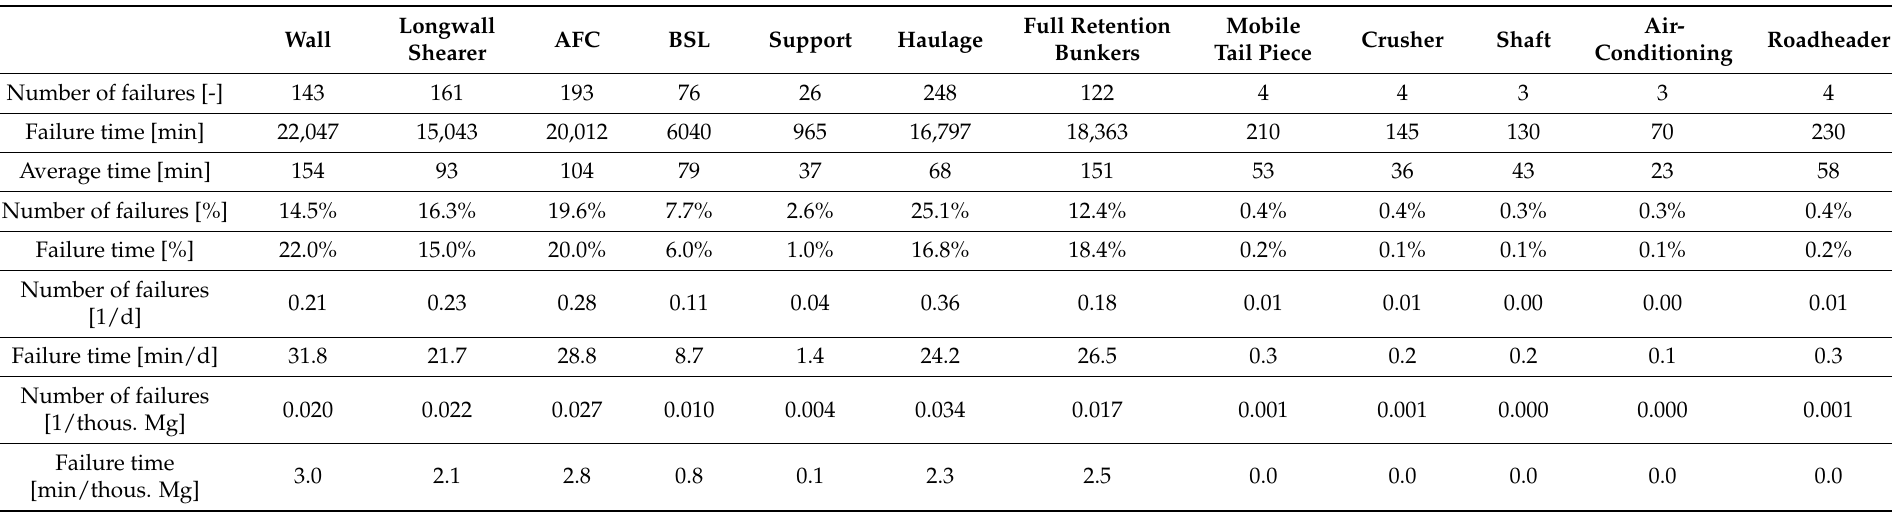
Table 4. Information on the time and number of failures of shearer